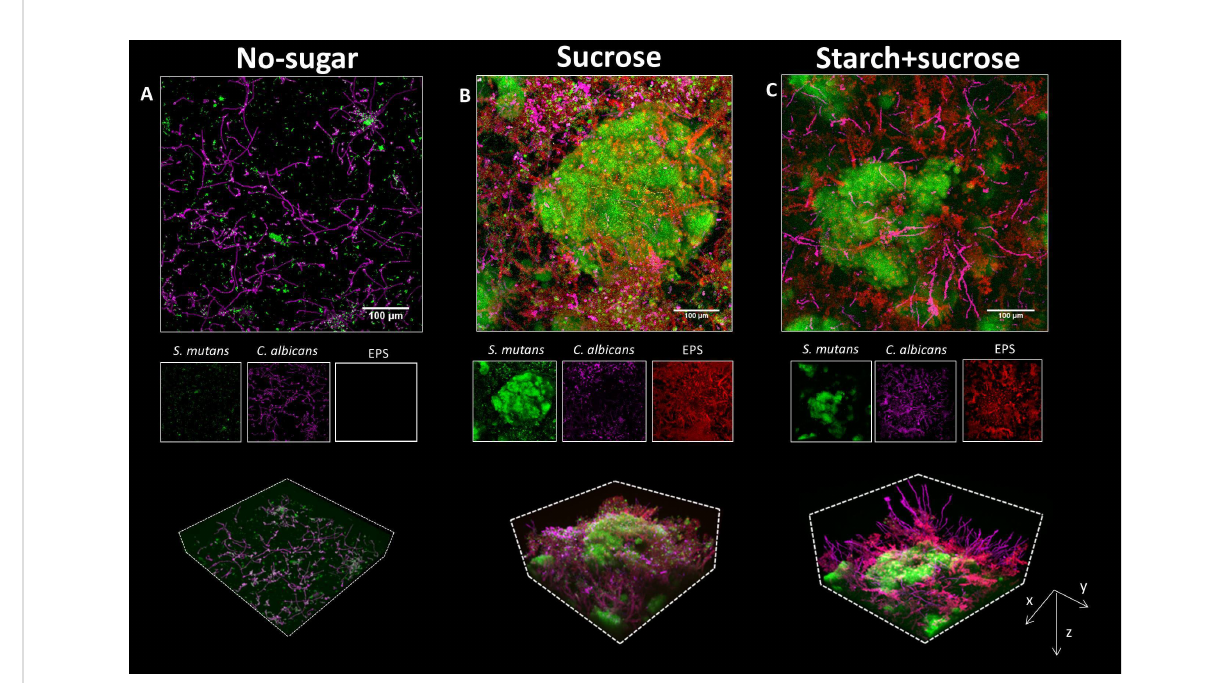
FIGURE 3 Bio fi lms formed by surface-bound inter-kingdom aggregates. (A – C) , confocal images of the 19h bio fi lms originated from aggregates mediated by different sugars, as indicated above the images. In each panel, the upper image shows the z projection of a large representative fi eld of view (640 m m × 640 m m; scale bar = 100 m m). The middle images show individual fl uorescence channels. The lower images are three-dimensional rendering of the confocal image illustrating the spatial structure of C. albicans and S. mutans , and EPS matrix. Green, S. mutans; purple, C. albicans; Red, EPS a